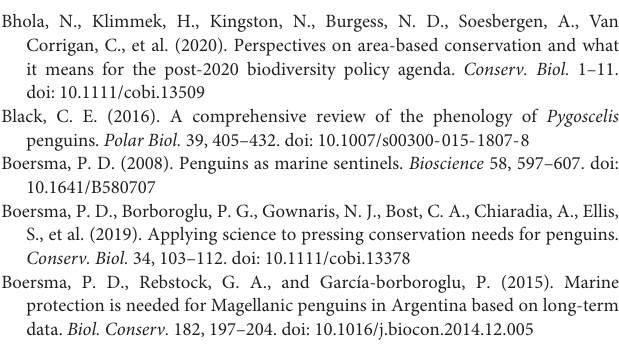
Supplementary Data Sheet 1 | Summarised data used for the marine IBA